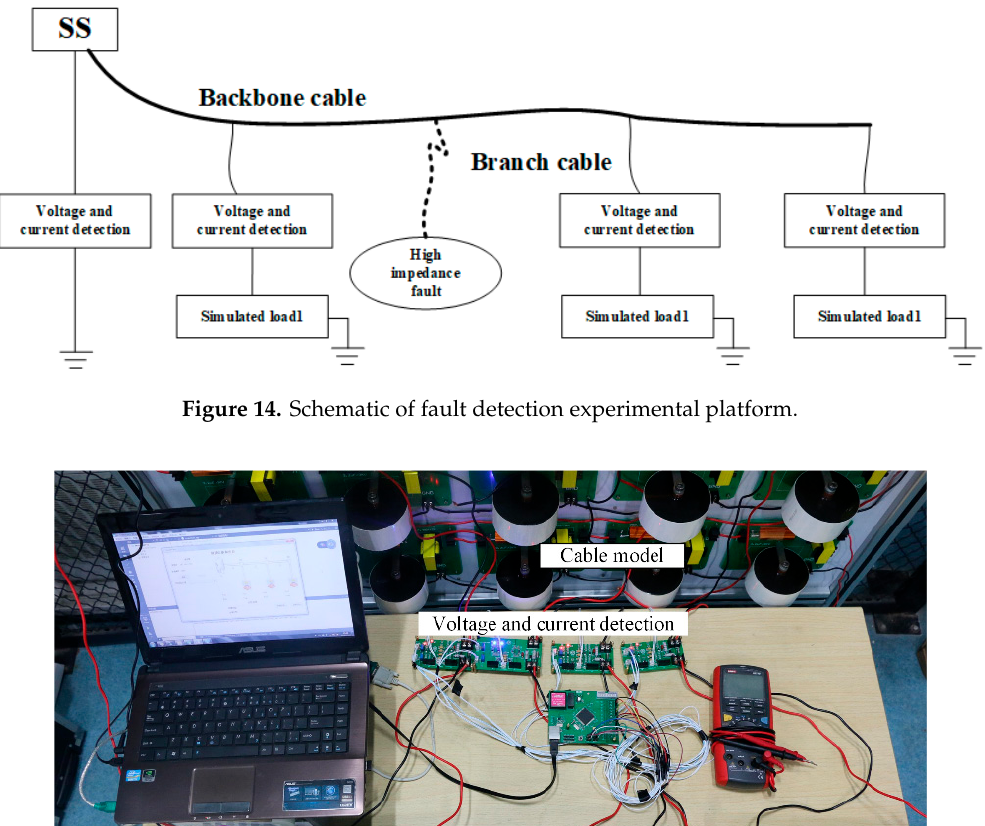
Table 4. Experimental results of fault detection.